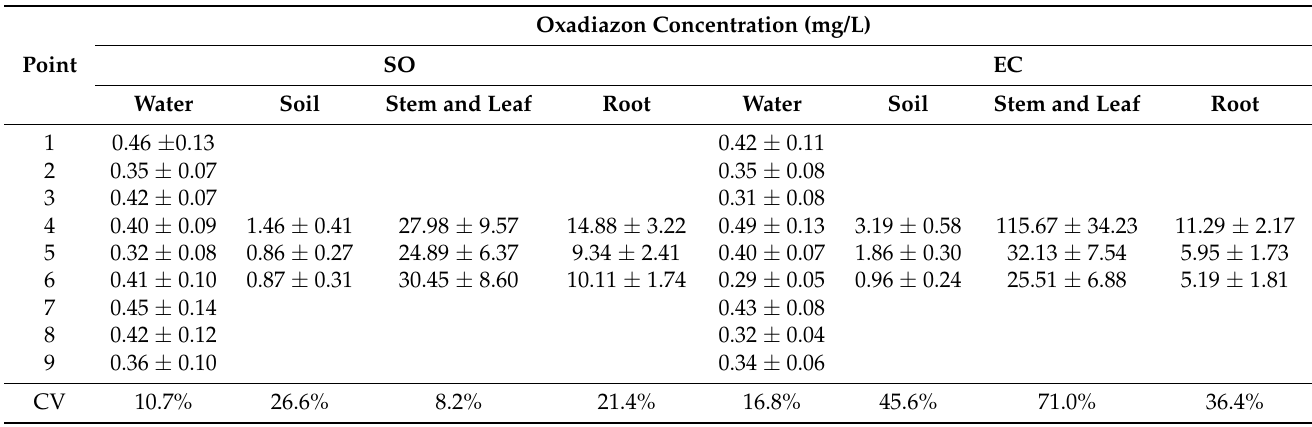
Table 2. Experimentally measured distribution of oxadiazon in water, soil, and the stems, leaves, and roots of the weeds after SO and emulsifiable concentrate (EC) are deposited on the water surface in a paddy field simulation system. Oxadiazon Concentration (mg/L) SO EC Point Water Soil Stem and Leaf Root Water Soil Stem and Leaf Root 0.46 ±